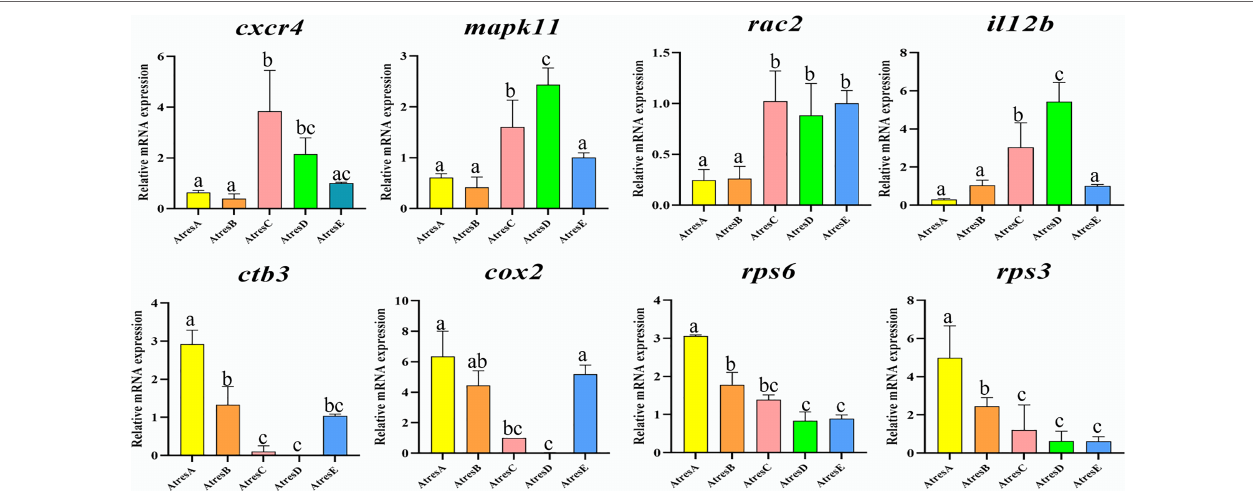
FIGURE 8 | Validation of eight DEGs by qRT-PCR. Three samples in each stage and, finally, 15 samples were used in qRT-PCR analysis. Meanwhile, three replicates in each sample were performed. All data were expressed as the mean ± SEM, and the statistical analysis was performed using GraphPad Prism 9 software to